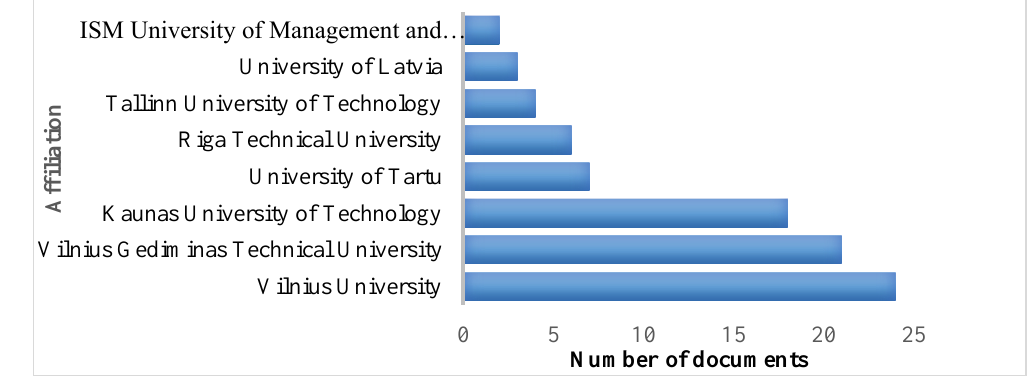
Fig. 6. Documents by